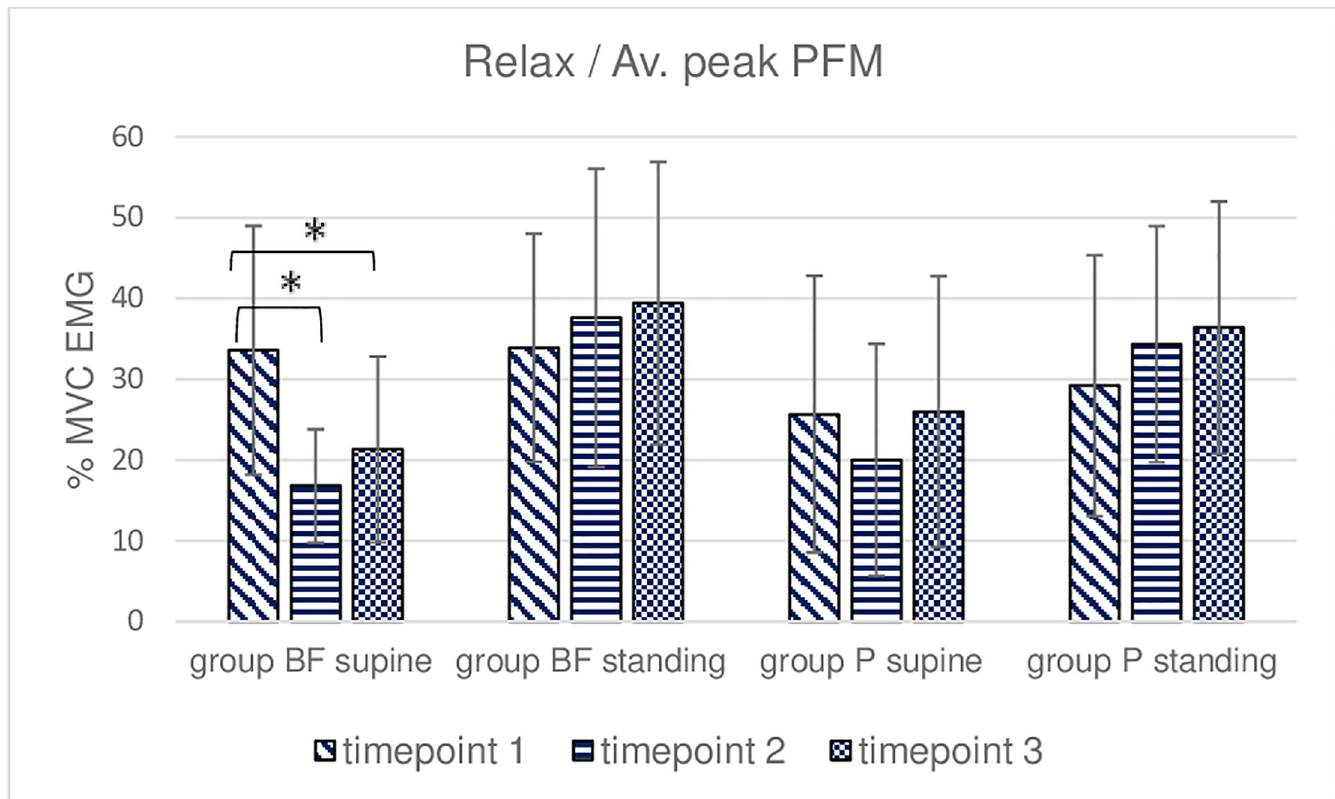
Fig 8. Intra- and intergroup analysis of sEMG average peak %MVC amplitudes of the relaxation of the pelvic floor muscles; p � Post-hoc Friedman’s rank sum